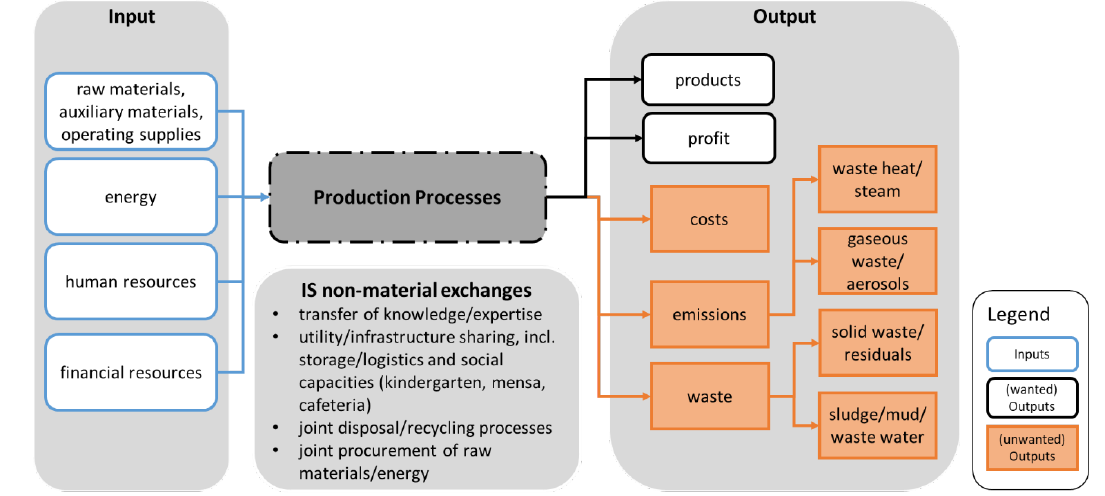
Figure 1. Schematic overview of a company ’ s points of contact for Industrial Symbiosis (IS) activities.